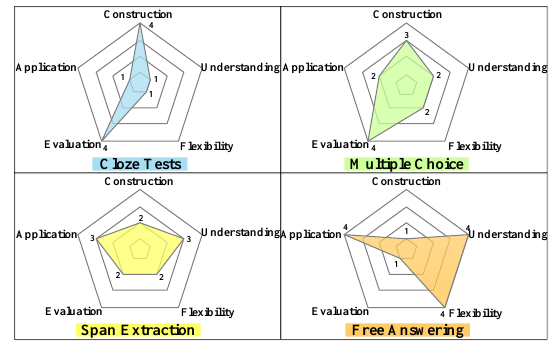
Figure 4. Comparison of different MRC tasks.